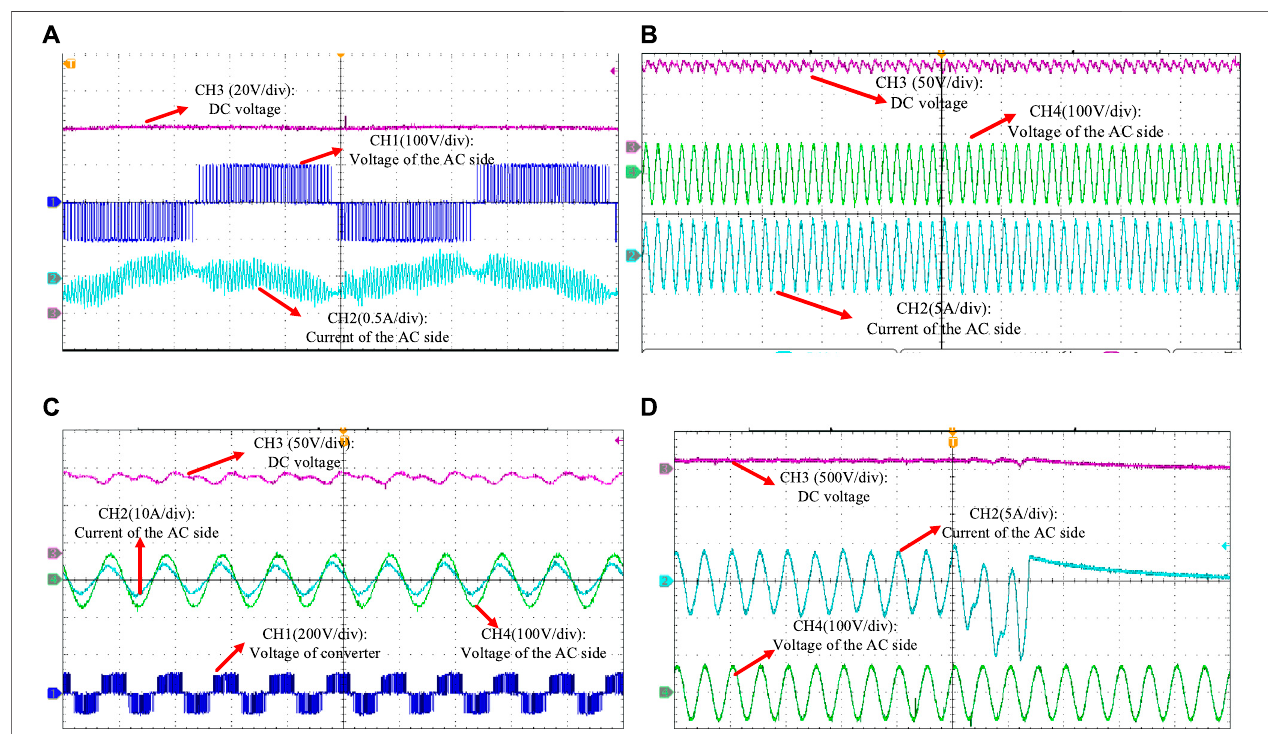
FIGURE15| TheHILexperimentresultof (A) zerotimedelayfortheconverterwithoutload, (B) zerotimedelayfortheconverterwithload, (C) T s timedelay, (D) 2 T s time delay.